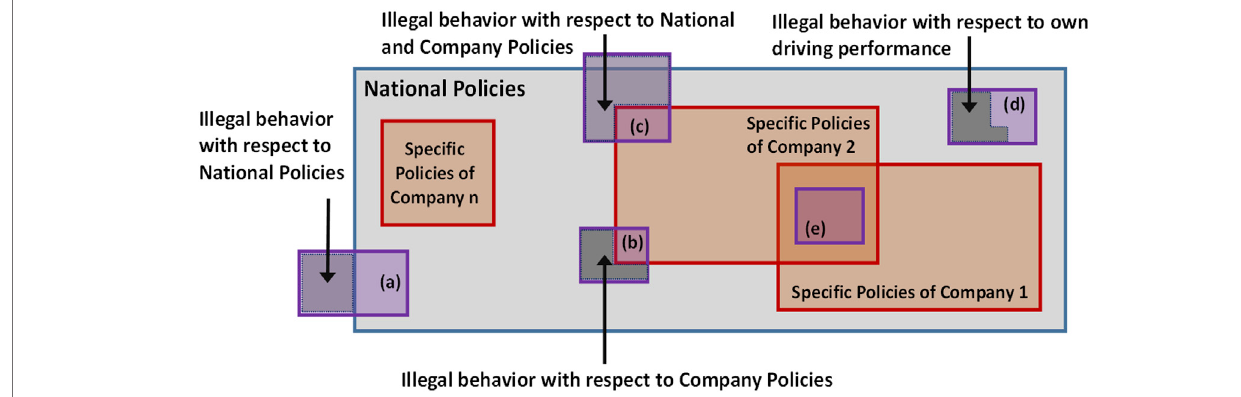
FIGURE 1 | Toward a framework of personalized road traf fi c policies.